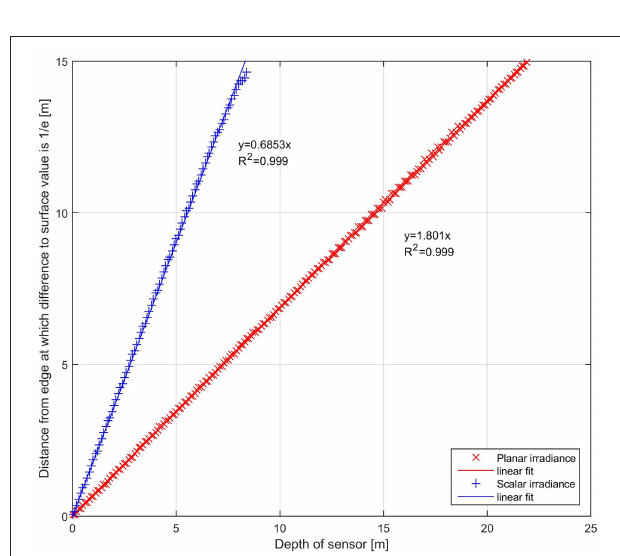
FIGURE 5 | This plot shows the distance from the edge at which the difference of the sensor reading from the true asymptotical value has decreased to 1/e of the difference of light transmission across the edge (e-folding